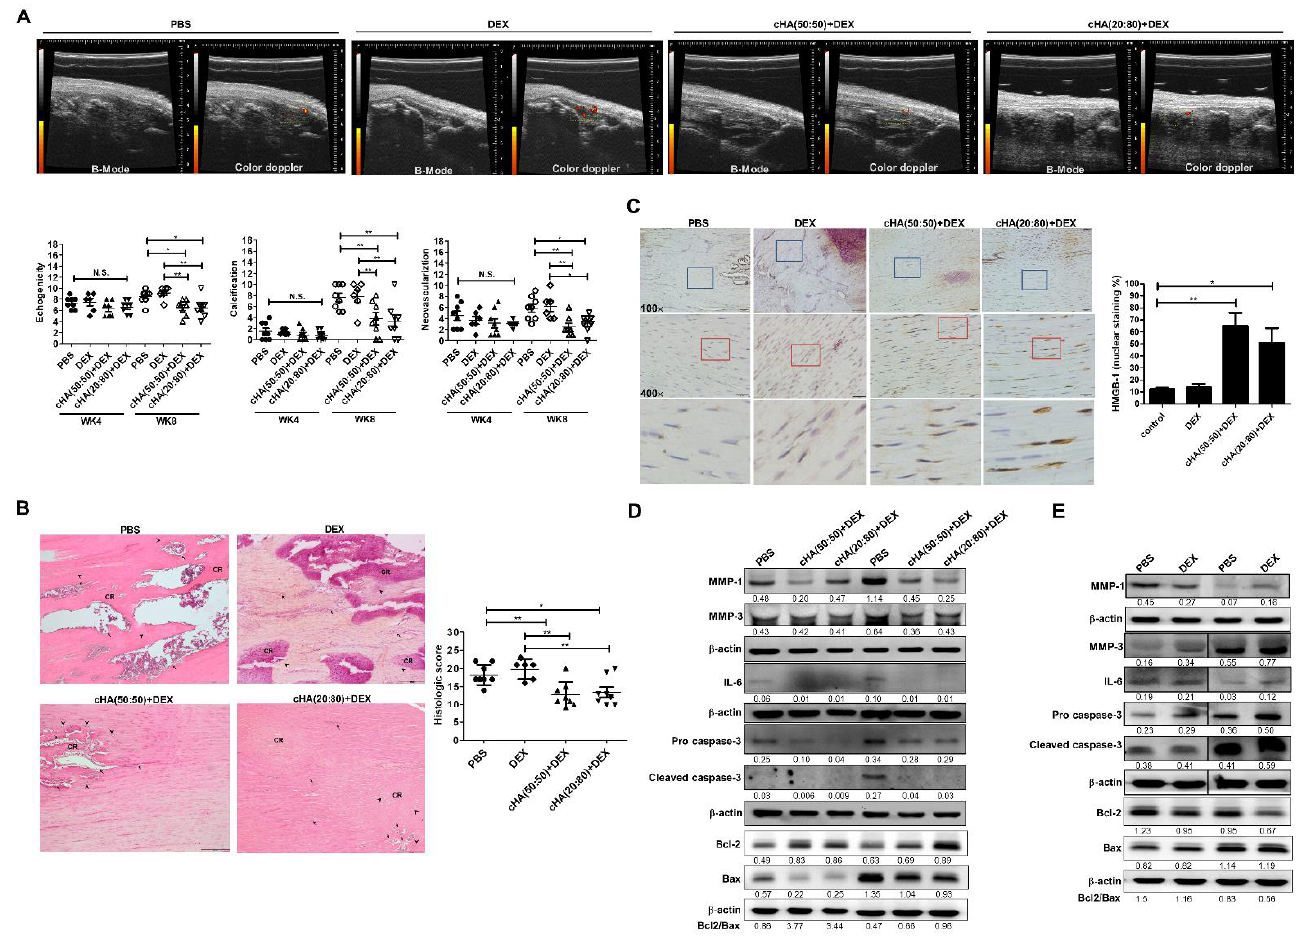
Figure 5. In vivo therapeutic effects and gene expressions in the experimental rat model. Four weeks after the intratendinous collagenase injection, the successfully induced rats under ultrasound examination were randomly allocated into four groups: PBS (control, n = 8), DEX only ( n = 6), cHA (50:50) + DEX ( n = 8), and cHA (80:20) + DEX ( n = 8). Para-tendinous injection was conducted according to the allocation. ( A ) Ultrasound examination was performed 4 and 8 weeks after collagenase injection. The B-mode and color doppler images at week 8 were demonstrated. The semiquantitative scores of ultrasound features were measured and recorded. ( B ) Hematoxylin and eosin (H&E) stainings and histologic scores of control (PBS)-, DEX-, cHA (50:50) + DEX-, and cHA (80:20) + DEX-treated tendons. Bars shown at × 100 magnification correspond to 200 µ M. CR: calcified region; arrowhead: chondrocyte-like cell; arrow: neovascularization. ( C ) Immunohistochem- ical staining of high mobility group box 1 (HMGB1) in the patellar tendons treated with PBS, DEX, cHA (50:50) + DEX, and cHA (20:80) + DEX. Blue boxed areas were shown at higher magnification in the panels ( × 400) beneath them. Red boxed areas were shown at higher magnification in the panels beneath them. Bars shown at × 100 and × 400 magnifications correspond to 50 and 20 µ M. Expression levels of IL-6, pro caspase-3, cleaved caspase-3, MMP-1&-3 treated with ( D ) PBS, cHA (50:50) + DEX, and cHA (20:80) + DEX or in the patellar tendons ( n = 2 in each group) treated with ( E ) PBS and DEX, as determined by immunoblotting. Values are the mean ± SEM. * p < 0.05, ** p <